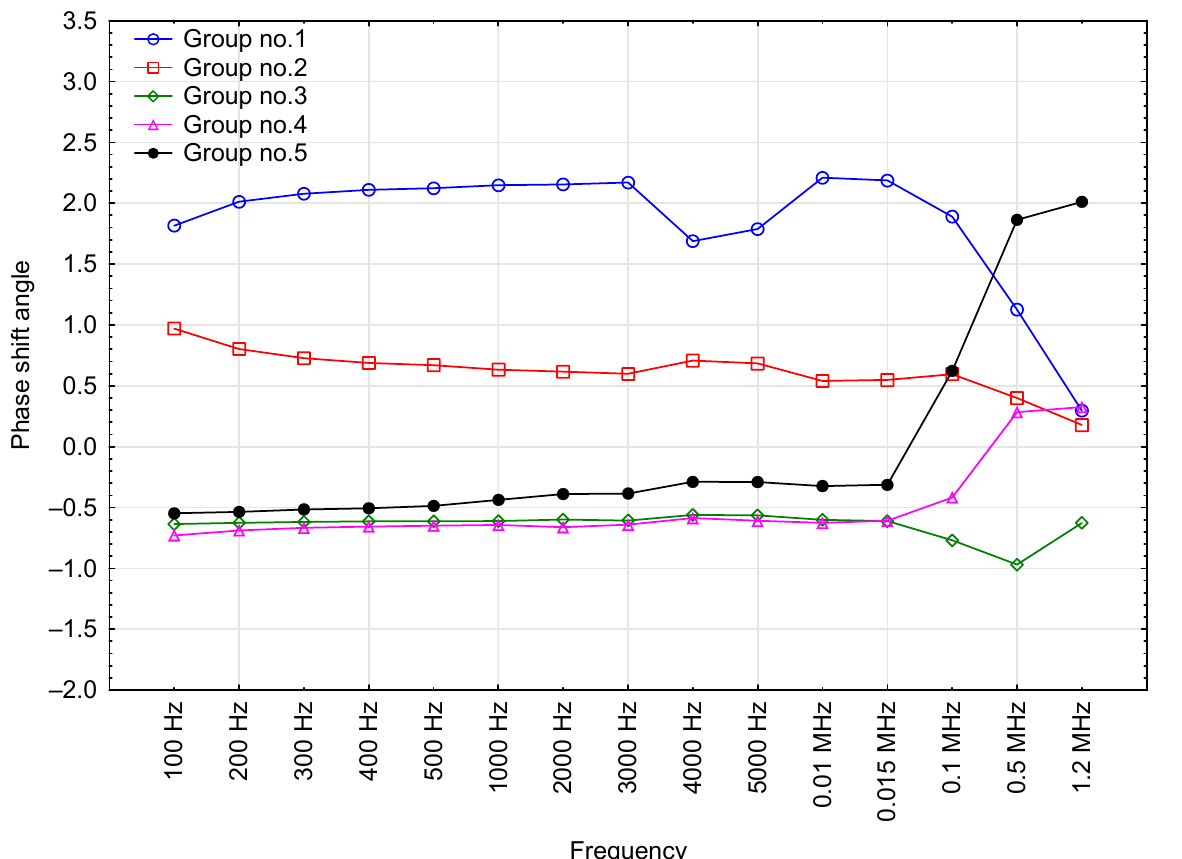
Figure 9. Effect of test voltage frequency on the average phase shift angle value for engine oils in each cluster (grouped by k-means).